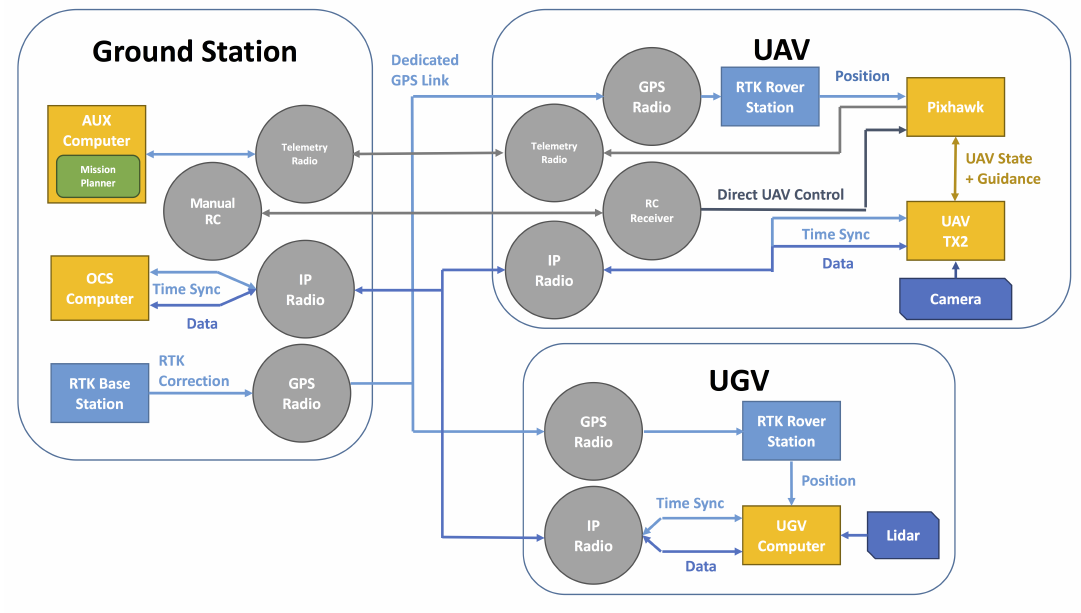
Figure 3. Diagram displaying the wireless links and sensor layout. OCS: operator control station; UAV: unmanned aerial vehicle; UGV: unmanned ground vehicle; IP: Internet